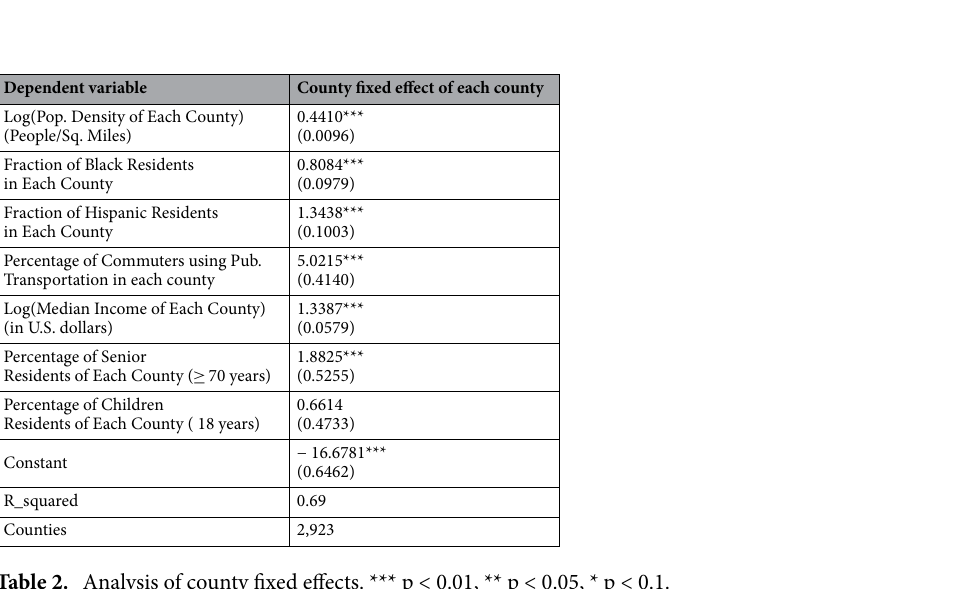
Table 2. Analysis of county fixed effects. *** p < 0.01, ** p < 0.05, * p <